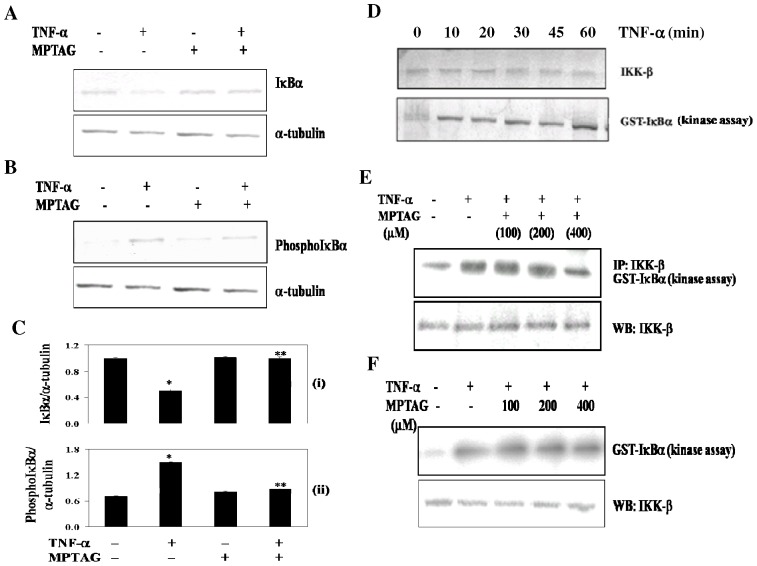
MPTAG prevents TNF-α-induced IκBα degradation by inhibiting the activation of IKK-β.(A–B) The cells were treated with MPTAG (400 µM) followed by induction with TNFα for 30 mins and total cell extracts were processed for western blot analysis using antibodies against IκBα, phosphoIκBα and α-tubulin. (C) The intensity of bands were densitometrically scanned and normalized with that of α-tubulin in panels (i) and (ii). The values presented are mean ± SEM. *p<0.005 vs. uninduced cells; **p<0.01 vs. TNF-α-induced cells, statistical significance was set at p<0.05. (D) The cells were treated with MG-132 (a proteosome inhibitor; 50 µg/ml) for 30 mins and then exposed to TNF-α (10 ng/ml) for the indicated times. Total cell extracts were prepared and immunoprecipitated with anti-IKK-β antibody followed by kinase assay using GST-IκBα as a substrate. The extracts were also subjected to western blot analysis using anti-IKK-β antibody. (E) The cells were treated with MPTAG and MG-132 and then induced with TNF-α for 30 mins followed by kinase assay and western blot analysis as stated above. (F) The total cell extracts were prepared from cells in absence and presence of TNF-α induction (10 ng/ml) and were immunoprecipitated with anti-IKK-β antibody. The kinase assay was performed in the absence or presence of the indicated concentrations of MPTAG. The extracts were also subjected to western blot analysis using anti-IKK-β antibody.